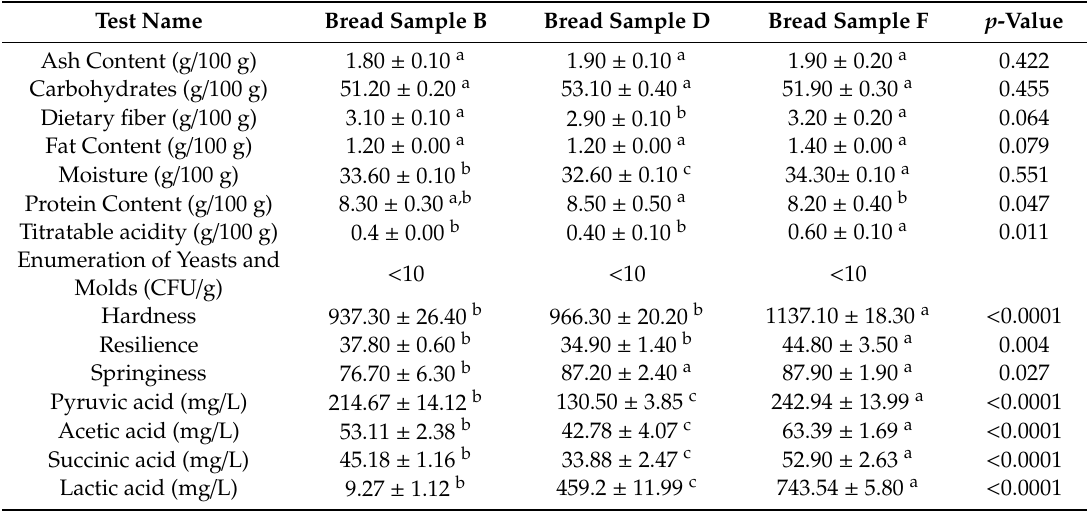
Table 5. Proximate, texture and carboxylic acid analysis for coconut water kefir fermented sourdough bread